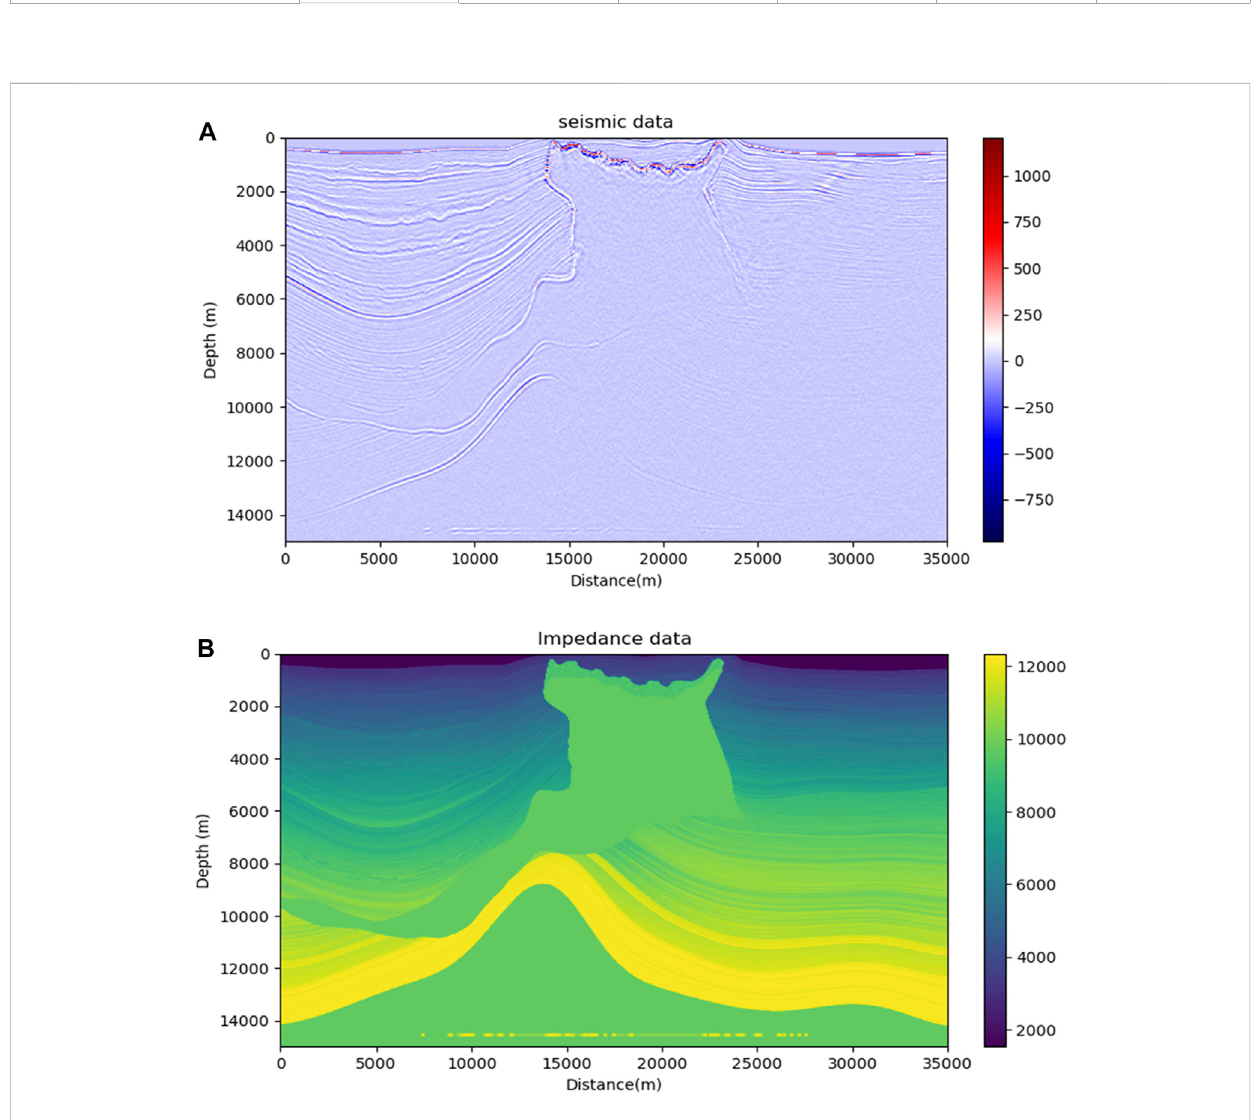
FIGURE 9 SEAM model. (A) Seismic data pro fi le. (B) Real acoustic impedance pro fi